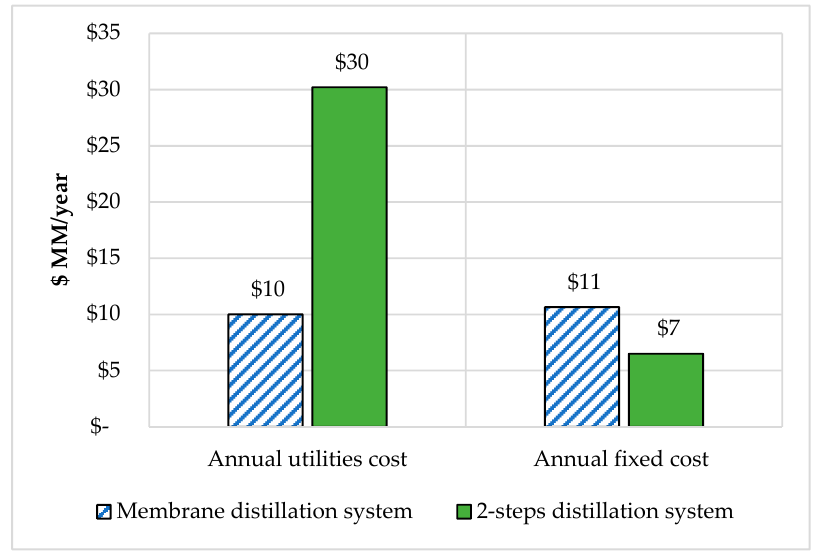
Figure 6. Comparison of variable and fixed cost of FW fermentation with a two-step distillation system and membrane distillation separation process.